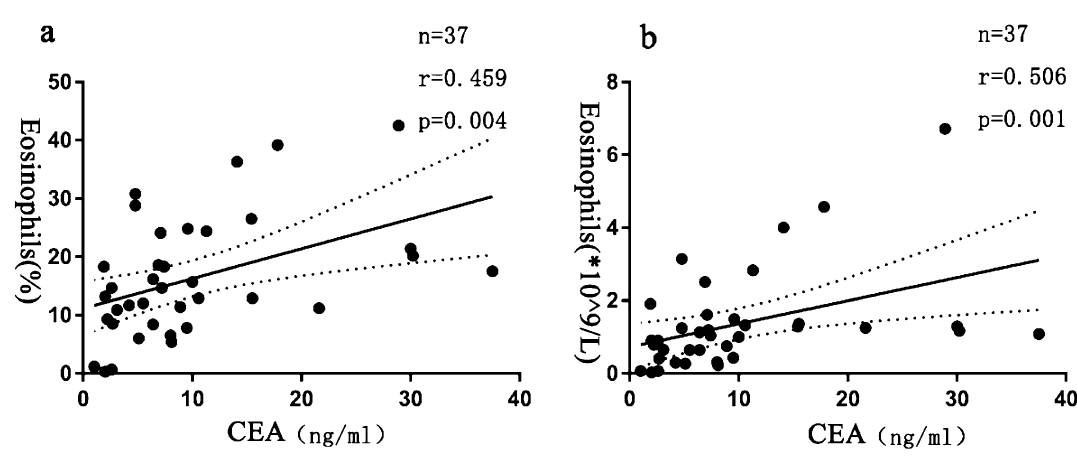
Figure 7. Correlation of CEA and EOS in ABPA patients. ( a ) Relationships among CEA and EOS%. ( b ) Relationships among CEA and EOS